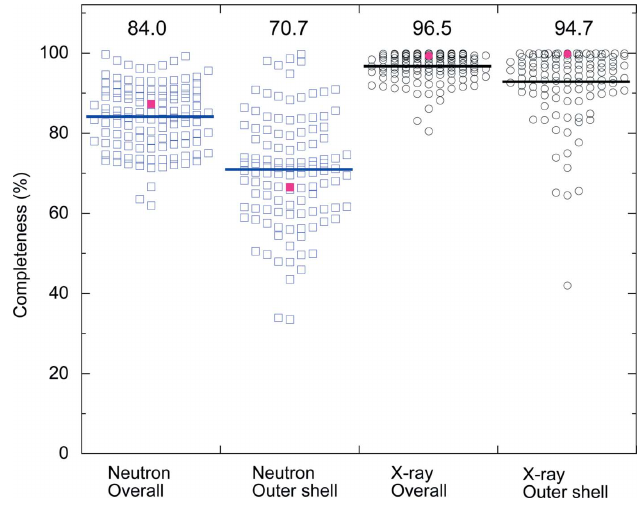
Figure 1 Distribution of the completeness values of neutron and X-ray diffraction data sets in joint-refined PDB data. Completeness values for the overall data and the outer shell were separately plotted for neutron (blue squares) and X-ray diffraction (black circles) data sets in PDB data ( n = 117) that were obtained by joint refinement. An average value for each group is indicated by solid lines and the numbers shown above (%). The corresponding values in our previous study (PDB entry 6l9c; Murakawa et al. , 2020) are shown as magenta squares and